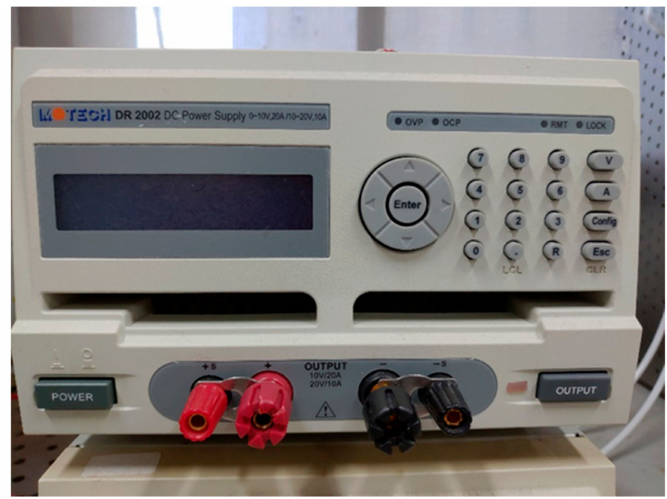
Figure 3. DR2002 power